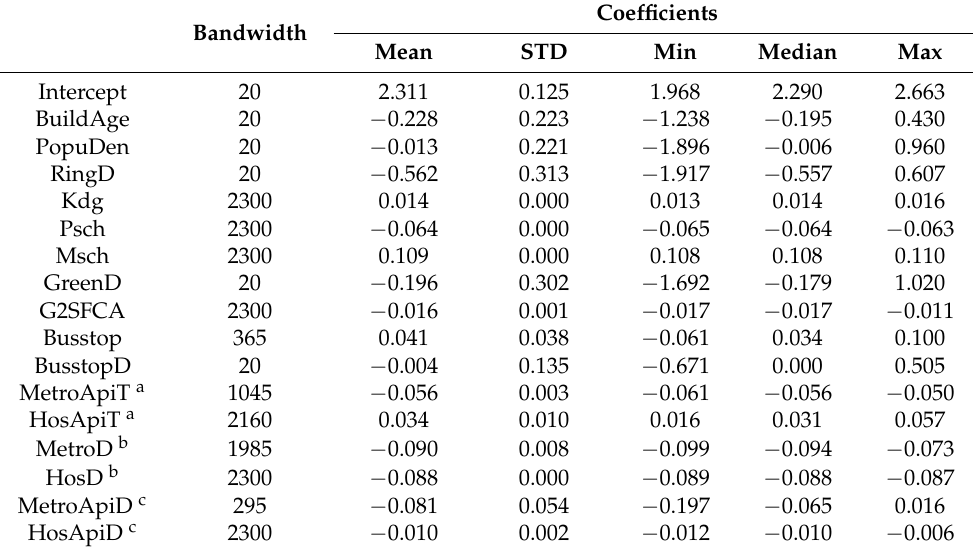
Table 4. Summary statistics for MGWR parameter